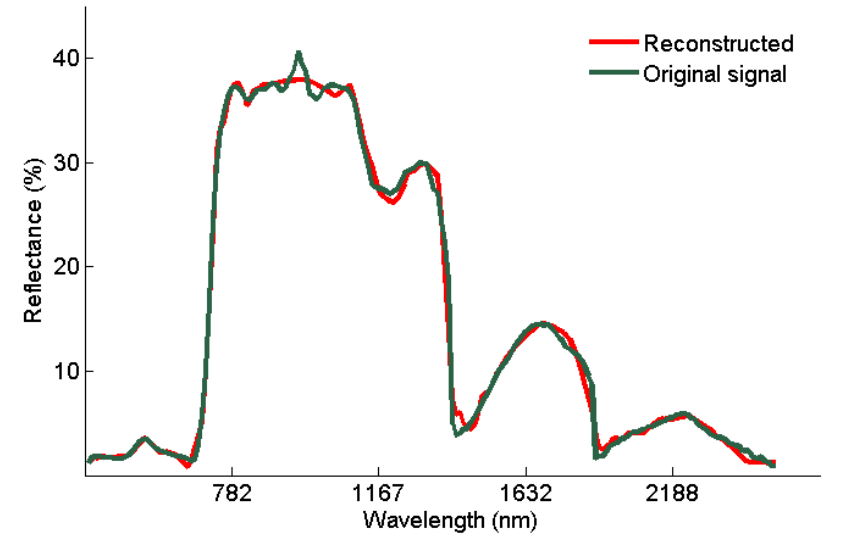
Figure 7. Reconstructed (with db3 coefficients having cumulative 99.99% energy) versus original signal for one of the